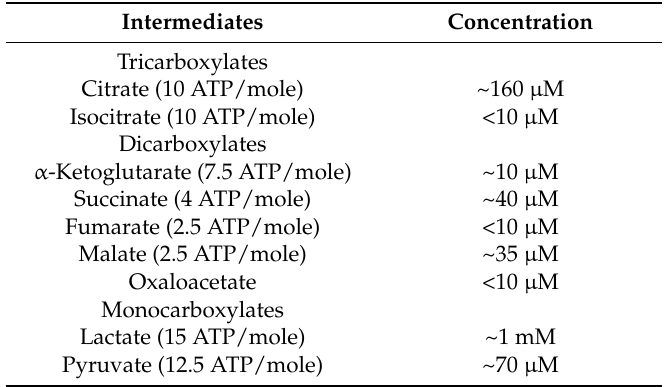
Table 1. Concentration and energy content of tricarboxylic acid cycle intermediates in